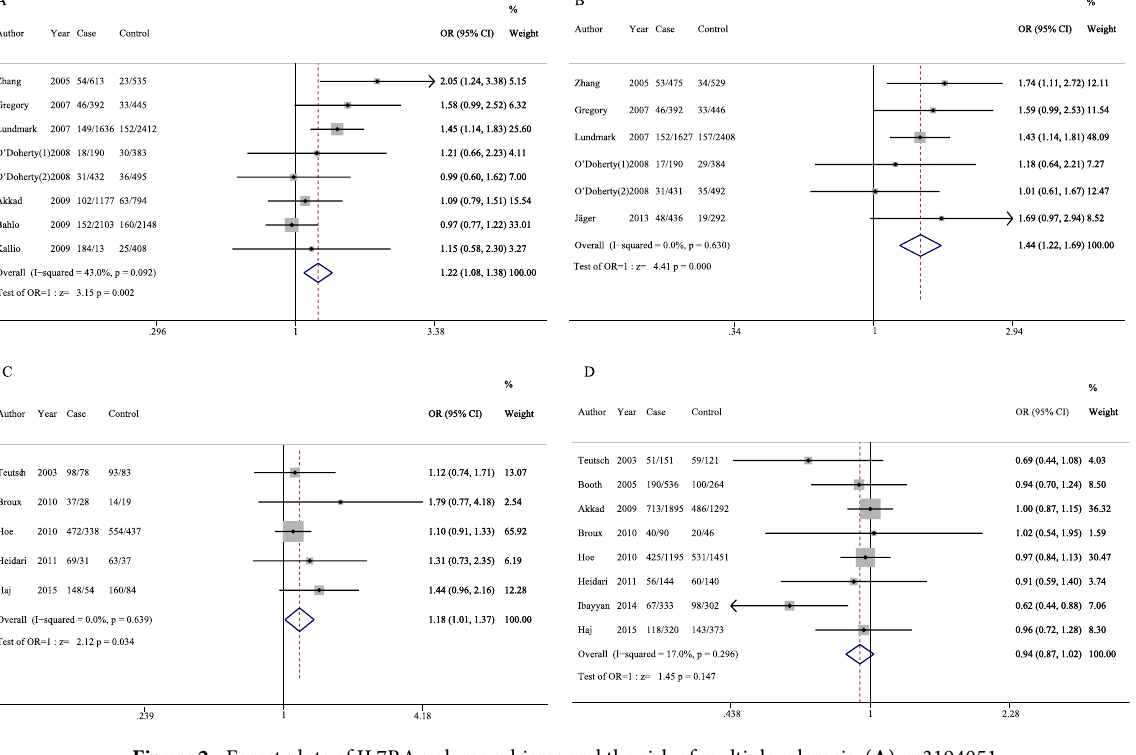
Figure 2. Forest plots of IL7RA polymorphisms and the risk of multiple sclerosis: ( A ): rs3194051 polymorphism under the recessive model (GG vs. GA + AA); ( B ): rs987107 polymorphism under the recessive model (TT vs. TC + CC); ( C ): rs11567686 polymorphism under the dominant model (GG + GA vs. AA); ( D ): rs11567685 polymorphism under the allelic model (C vs. T).